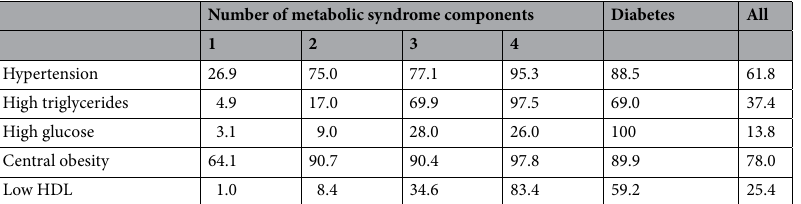
Table 3. Overview of the percentage of participants with a given number of MetS components or diabetes that fulfills each of the specific components. E.g., 75% of participants with two of the MetS components have hypertension as one of them.